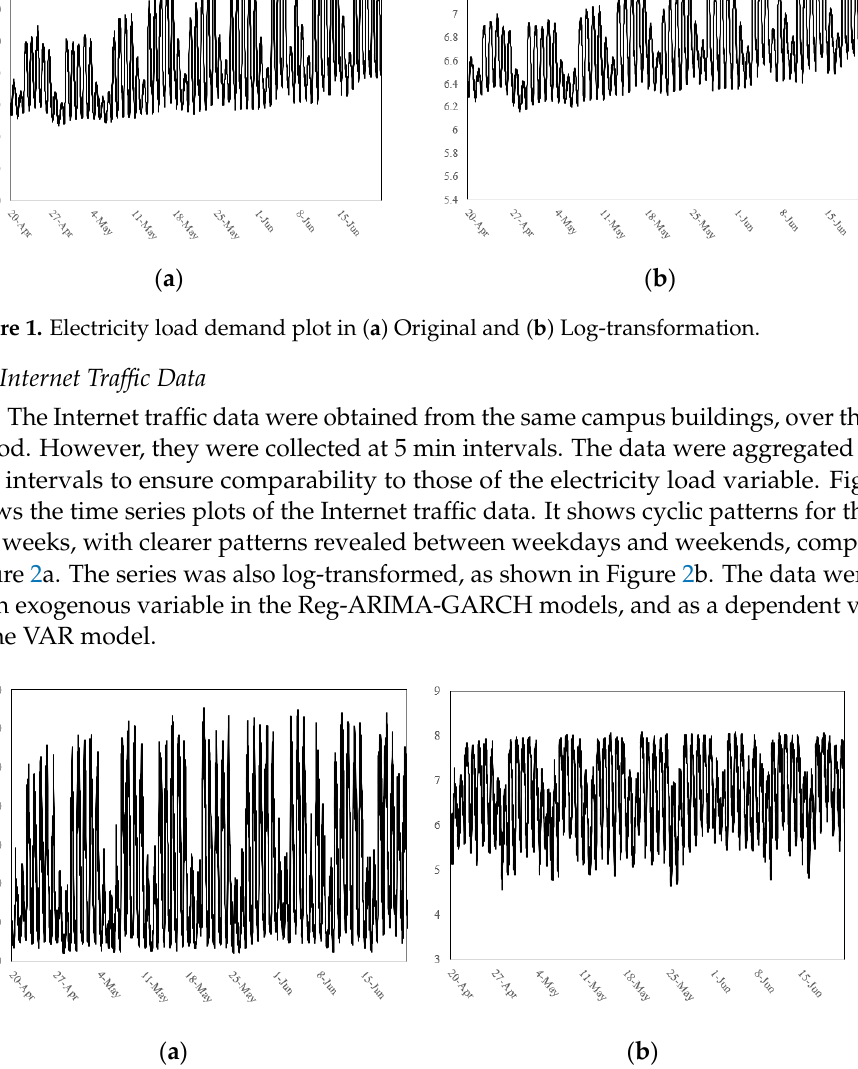
Figure 2. Internet traffic demand plot in ( a ) Original and ( b ) Log-transformation.